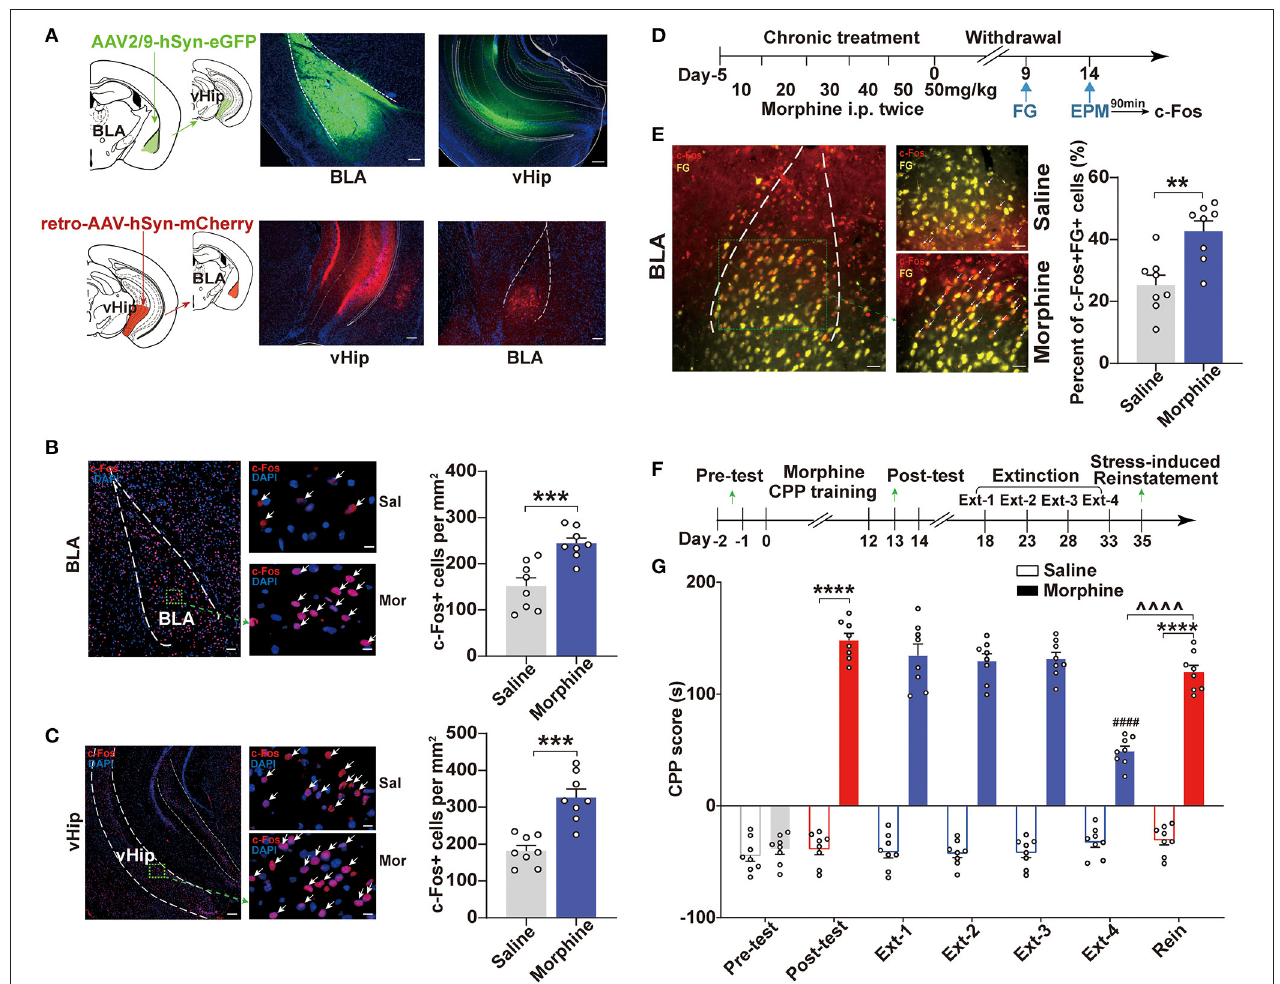
FIGURE 2 | BLA to vHip projections are involved in the anxiety-like behaviors induced by morphine withdrawal. (A) Schematic for tracing projections from the BLA to the vHip in wild-type mice. Representative coronal images of the injection site and tracing terminals. (Top) The anterograde virus AAV2/9-hSyn-eGFP was delivered in the BLA. (Bottom) The retrograde virus retro-AAV-hSyn-mCherry was delivered in the vHip. Scale bar: 200 µ m. Representative immunofluorescence images of c-Fos (red) in the BLA [ (B) , left] and vHip [ (C) , left]. The nuclei were stained with DAPI (blue). Scale bar: 200 µ m. Arrows indicate neurons co-labeled with c-Fos. Regions enclosed in a green box are shown at higher magnification in the images to the right. Scale bars: 50 µ m. The numbers of c-Fos-positive neurons per mm 2 in the BLA [ (B) , right] and vHip [ (C) , right]. (D) Timeline of c-Fos and fluorogold (FG) co-expression in BLA of Mor-A mice. [ (E) , Left] Representative coronal image of c-Fos (red) and fluorogold (FG, yellow) immunostaining in the BLA. Scale bar: 100 µ m. Regions enclosed by a green box are shown at higher magnification in the images to the right. Arrows indicate neurons co-labeled with c-Fos and FG. Scale bars: 50 µ m. (Right) The percentage of neurons co-labeled with c-Fos + and FG + relative to FG in the BLA. (F) Schematic of the experimental design for the training and testing of morphine-CPP acquisition, extinction, and reinstatement. (G) CPP scores in the morphine-CPP expression, extinction, and reinstatement tests. Morphine-induced CPP, extinction at Ext-4 and reinstatement induced by stress. In the CPP results, #: comparison between the Extinction-4 of morphine group and the post-test of morphine group, ∧ : comparison between the reinstatement of morphine group and the Extinction-4 of morphine group; *: comparison between the 2 indicated groups. BLA, basolateral amygdala. vHip, ventral hippocampus. Data are expressed as the mean ± SEM. ** P < 0.01, *** P < 0.001, **** P < 0.0001, ∧∧∧∧ P < 0.0001, #### P < 0.0001. n =